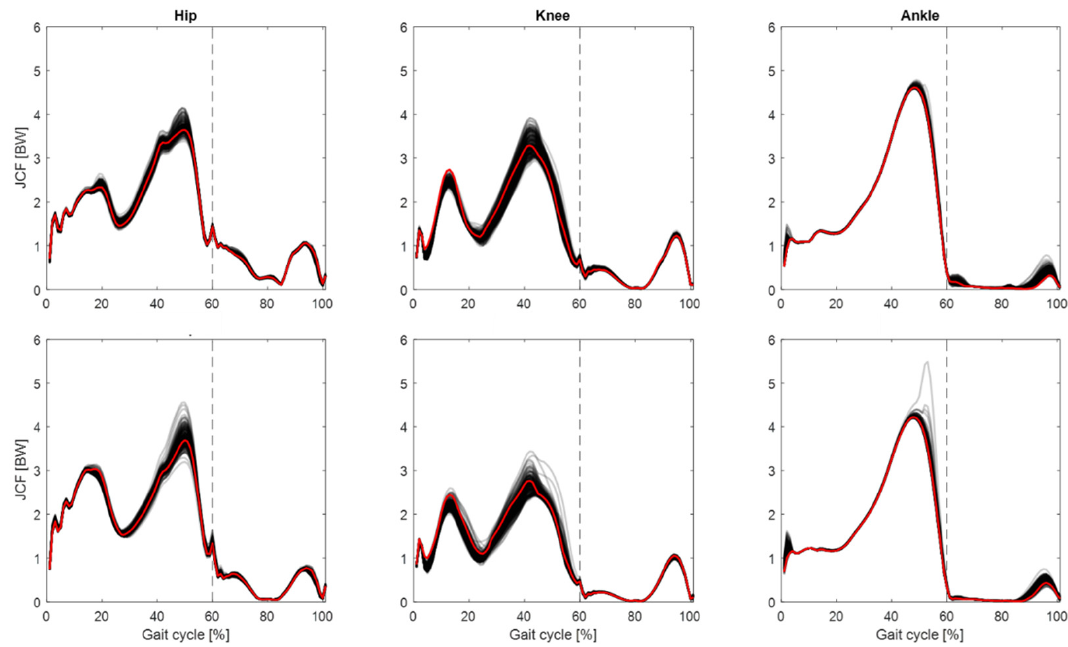
Figure 2. Two hundred JCF curves obtained by sampling F max distribution (black lines) and baseline curve (red line) obtained with SGM (top row) and SSM (bottom row); dashed vertical line indicates toe-off.